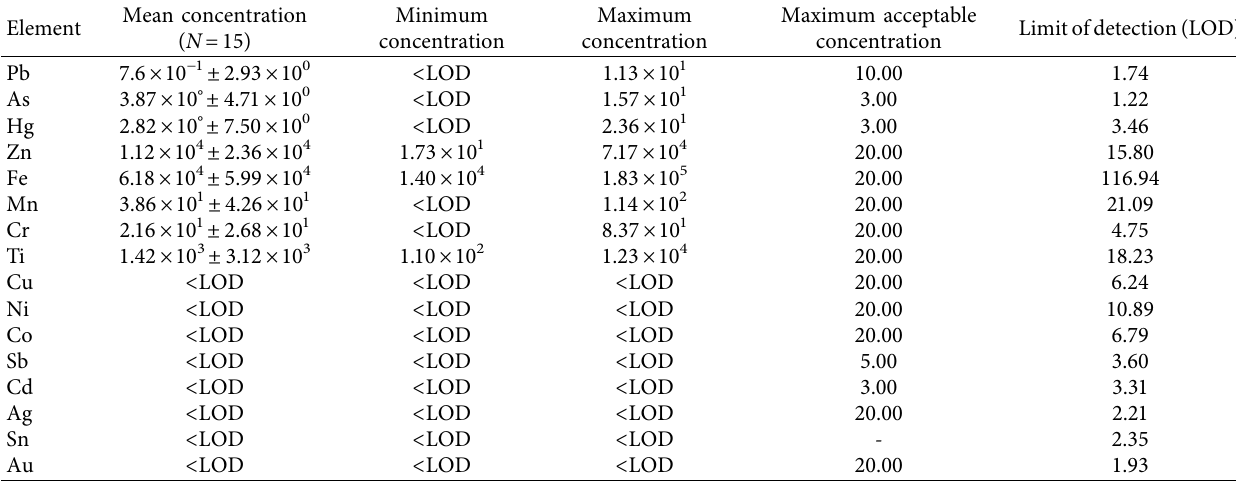
Table 1: Elemental concentrations (mean ± SD, minimum and maximum) of facial powders ( μ g/g). Mean concentration Minimum Maximum Element ( N � 15) concentration